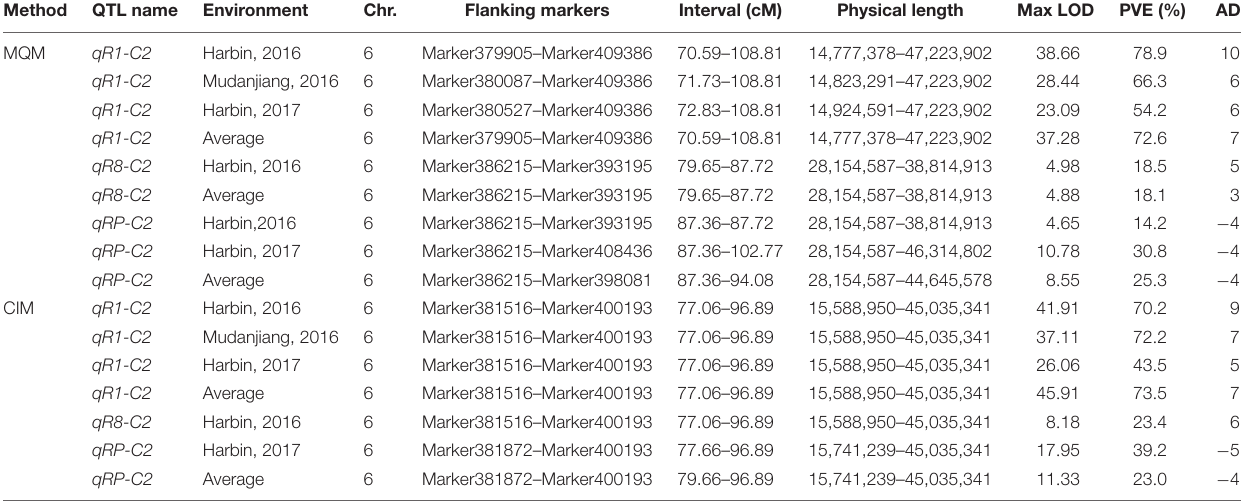
TABLE 4 | Detail information about the stable QTLs in SE population.